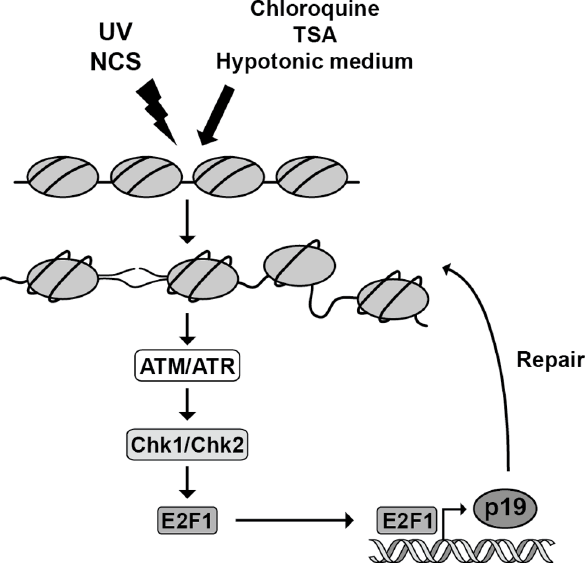
Figure 7. Chromatin-based defects as inducers of p19 protein. Chromatin structure defects can trigger ATM/ATR and Chk1/Chk2 activation leading to an increase in E2F1 protein levels as a result of transcriptional induction. E2F1 upregulation induces the transcription of p19 which, in turn, promotes DNA repair.